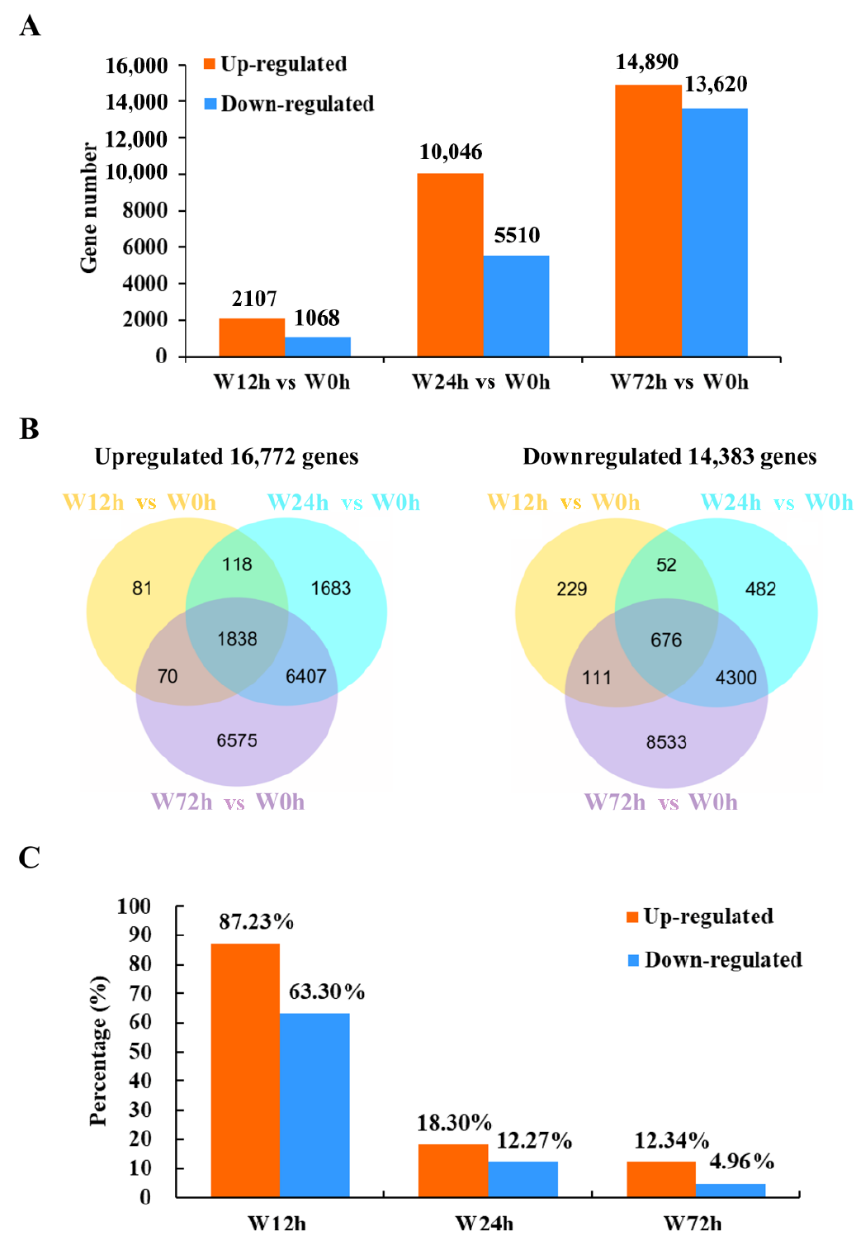
Figure 2. Summary of DEGs after different periods of waterlogging. ( A ) number of DEGs; ( B ) venn diagram of the number of DEGs after different durations of waterlogging; ( C ) percentage of the number of co-expressed DEGs to the number of DEGs induced after different durations of